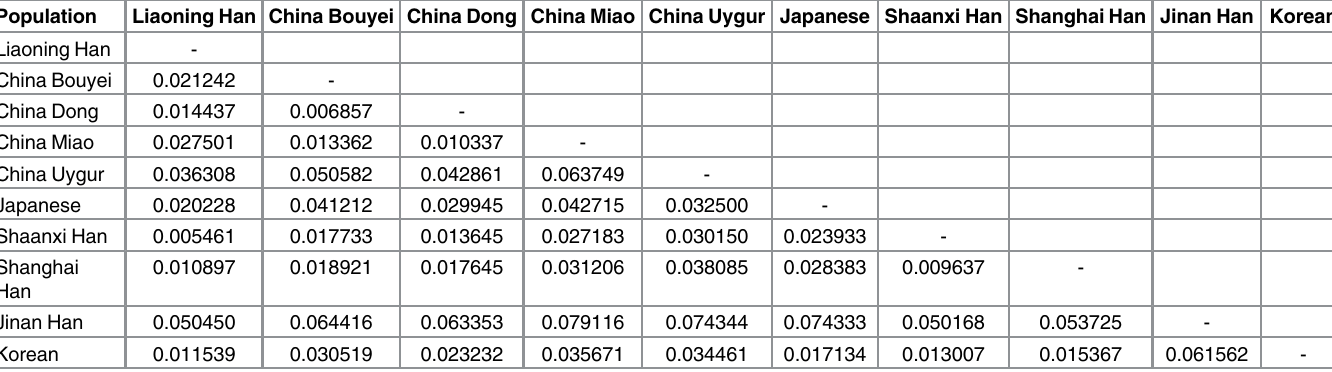
Table 2. Genetic distances between all pairs of populations (Phylip software according to